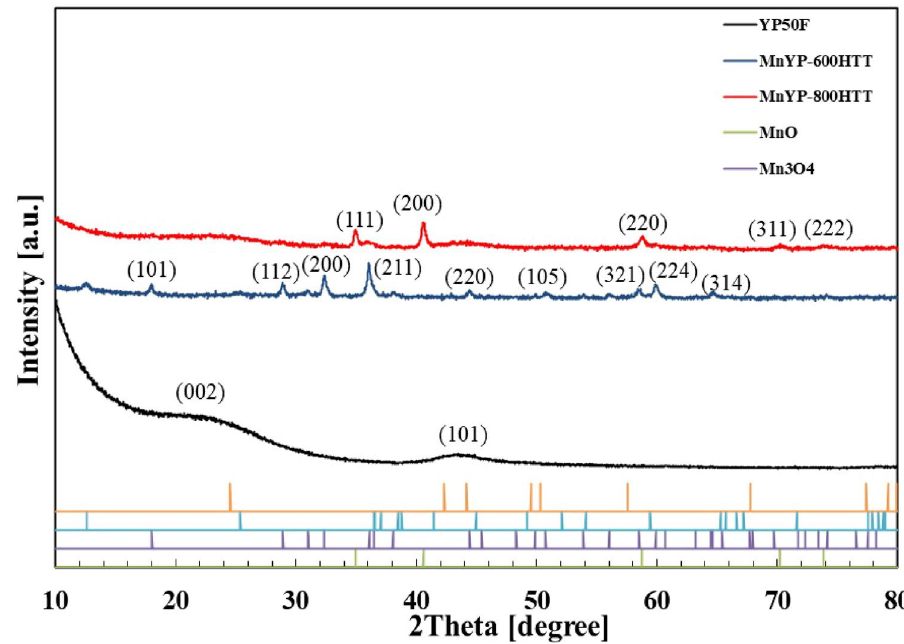
Figure 2. XRD pattern of Mn-doped MnYP-600HTT and